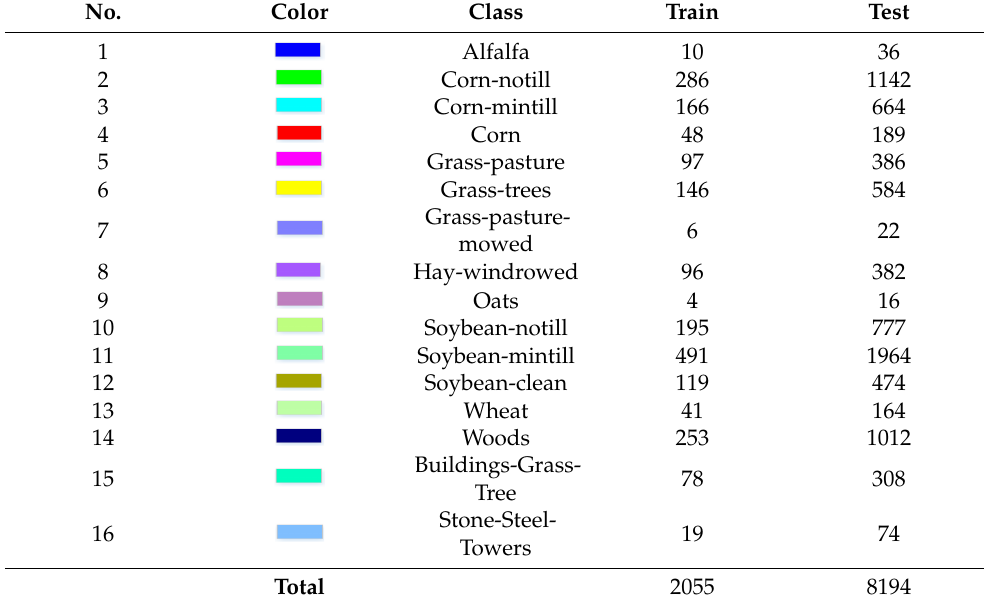
Table 3. The information of sample numbers of the Houston 2013 dataset.